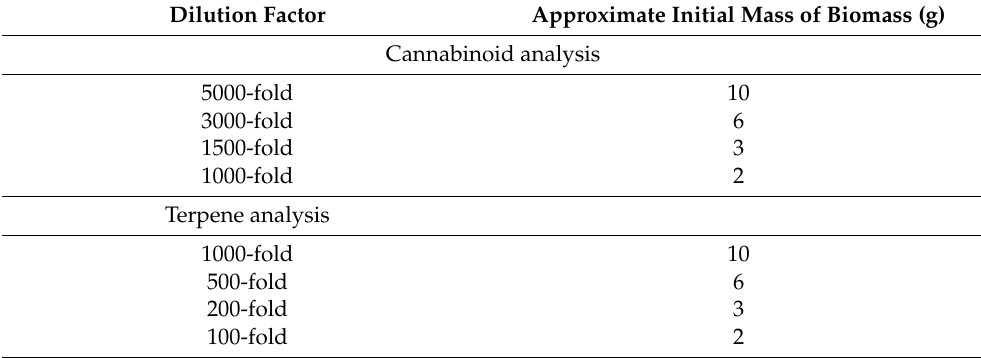
Table 8. Dilution factors used for cannabinoid and terpene analyses of cannabis biomass used for extraction. Dilution Factor Approximate Initial Mass of Biomass (g) Cannabinoid analysis 5000-fold 10 3000-fold 6 1500-fold 3 1000-fold 2 Terpene analysis 1000-fold 10 500-fold 6 200-fold 3 100-fold